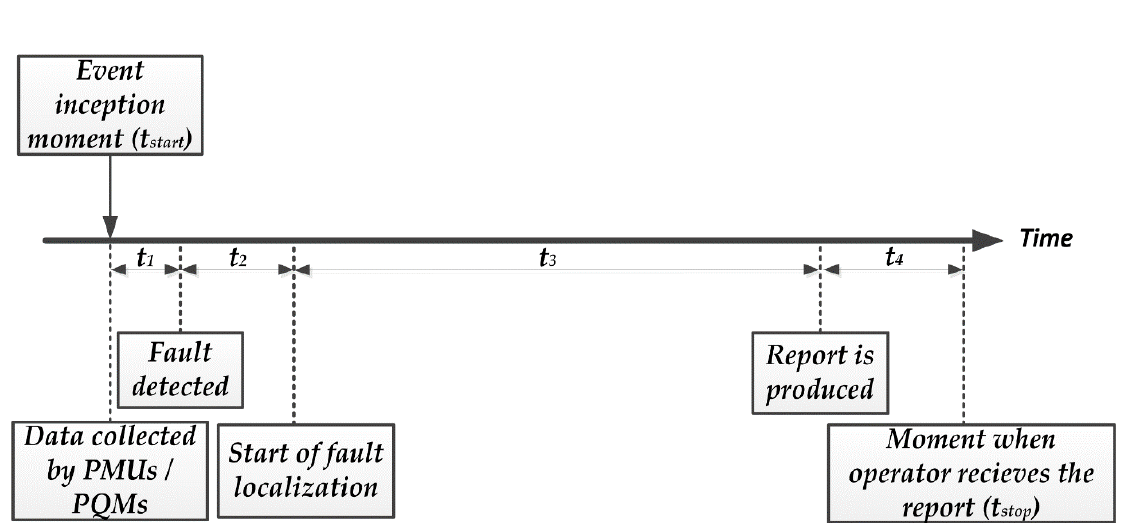
Figure 7. Time delay of the fault localization algorithm (FLA) components.